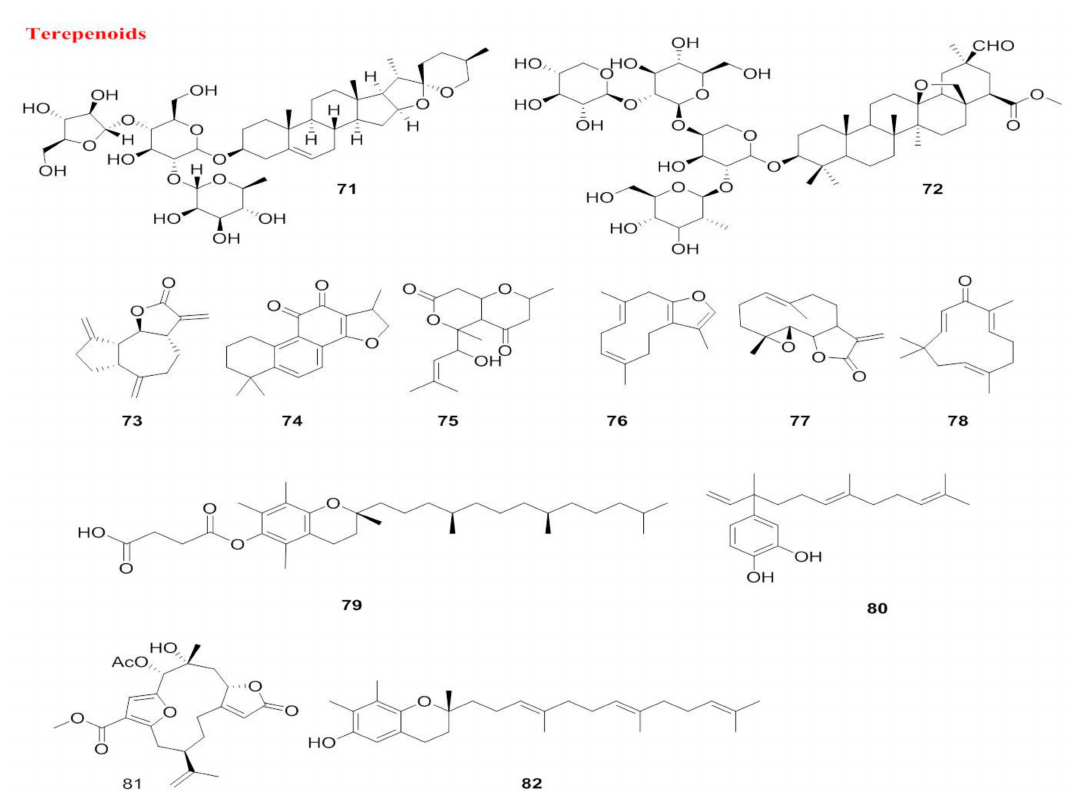
Figure 8. Chemical structures of terpenoids. Neoalbaconol (14), guttiferone K (15), oridonin (16), paclitaxel (17), gelomulide K (18), tanshinone IIA (19), helenalin (20), ursolic acid (21), ginsenoside compound K (22), frondoside A (23), oblongifolin C (24), isobavachalcone (59), cucurbitacin B (60), garcinol (70), polyphyllin D (71), saxifragifolin D (72), dehydrocostuslactone (73), cryptotanshinone (74), pimpinelol (75), furanodiene (76), parthenolide (77), zerumbone (78), α -tocopheryl succinate (79), 4-nerolidylcatechol (80), 7-acetylsinumaximol B (7-AB)